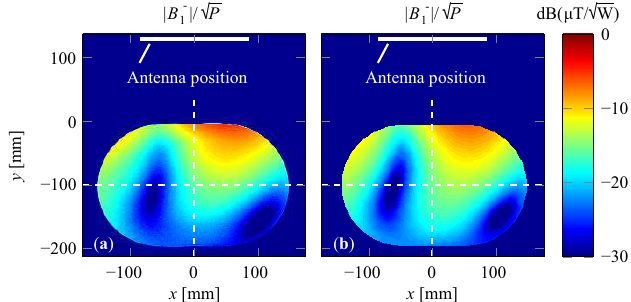
√ (cid:12) ( r ) (cid:12) (cid:12) / P of the four-channel coil array for a calibration factor of Figure 9. Normalized SNR values (cid:12) B − √ 1 K cal = 270.0 W/µT in a transversal plane: ( a ) measurement, ( b ) model. The parameters of the model are F 2 P , min = 0.66dB, F of f = − 0.19dB, r 2 P , opt = 0.1 − 0.36i for the pre-amplifiers, R C , l = 2.4 Ω for the